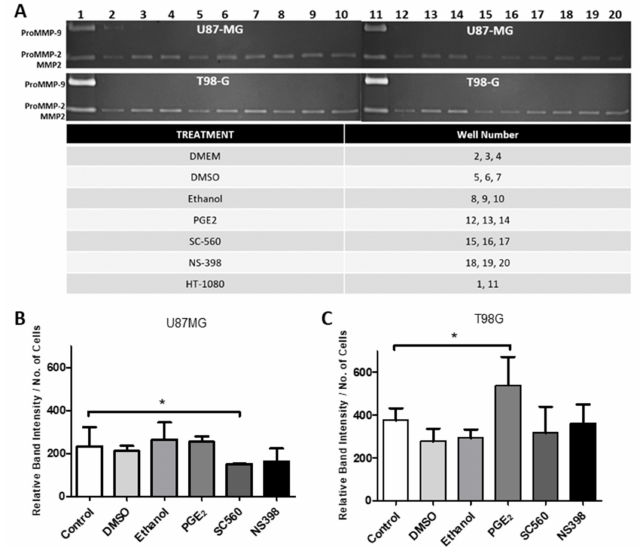
Figure 13. Gelatin zymography of GBM cells after treatment with exogenous PGE 2 or COX inhibitors. ( A ) Cells were treated for 24 h with PGE 2 (10 µ M), SC560 (50 µ M) or NS398 (50 µ M) and the serum- free medium was used for gelatin zymography. Band intensity was normalized to the number of cells present after 24 h of treatment. ( B ) ProMMP2 activity in U87MG cells; ( C ) ProMMP2 activity in T98G cells. Data are presented as mean + SEM, n = 3. A two-way ANOVA with a Bonferroni post-test was performed. Differences were considered significant at p < 0.05. * = p <